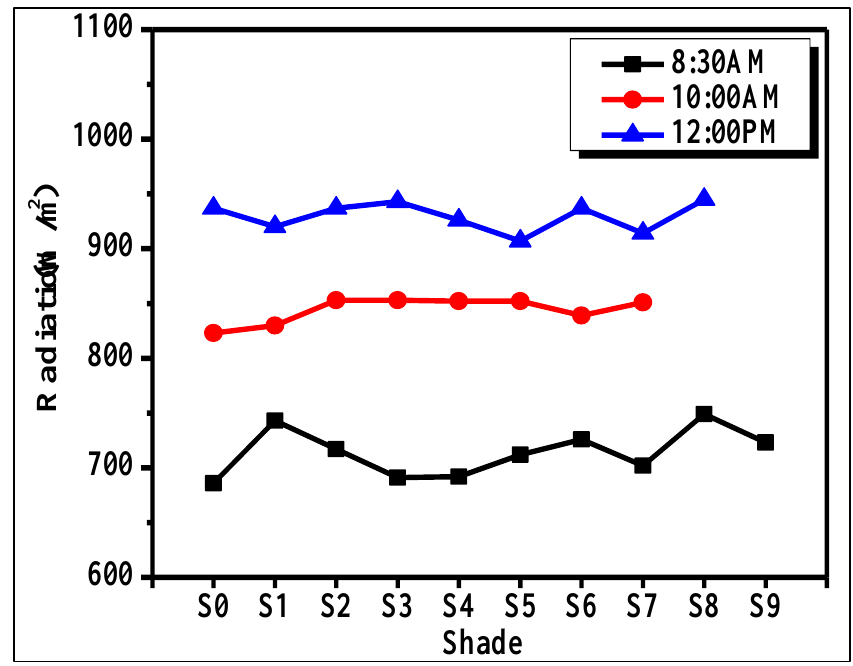
Figure (5): Radiation density variation with partial shade